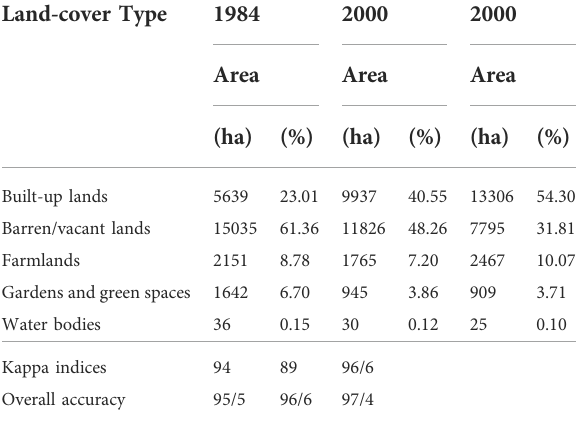
TABLE 2 Land use area changes during the 1984, 2000 and 2020 periods in Tabriz. Land-cover Type